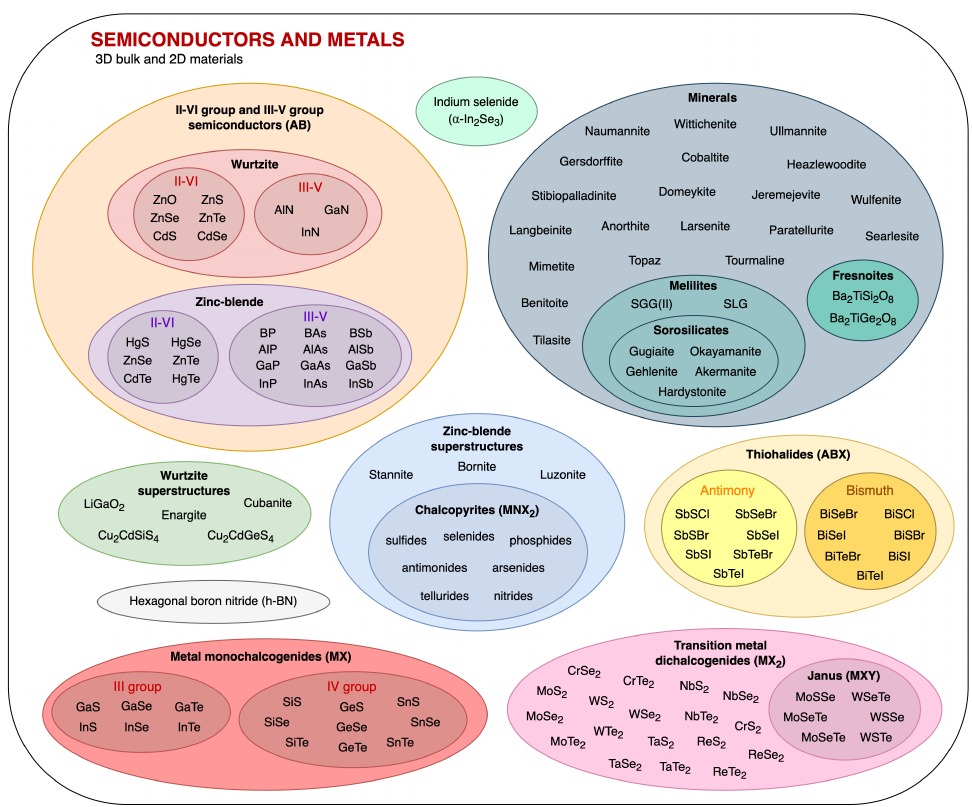
Figure A4. The class of semiconductors and metals featuring II-VI and III-V group semiconductors, minerals, thiohalides, metal monochalcogenides and transition metal